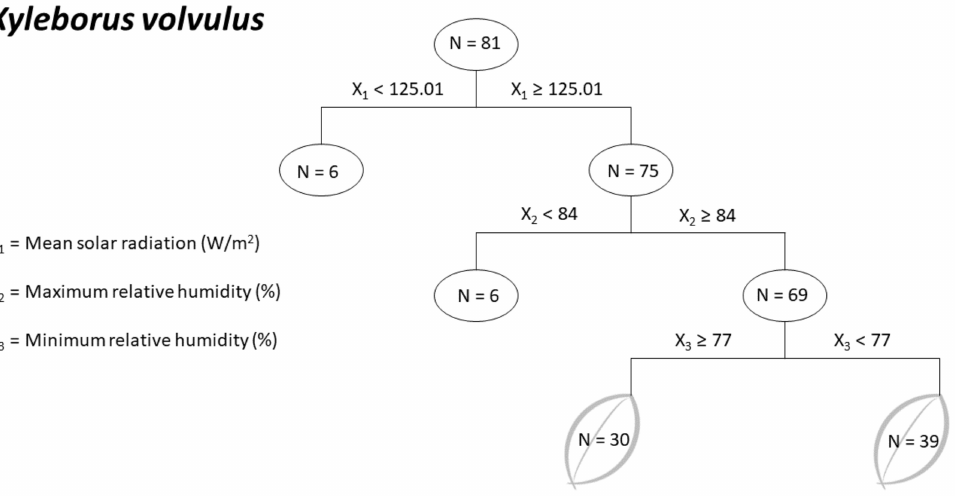
Figure 8. Decision tree schematic for Xyleborus volvulus abundance using weather conditions as explanatory variables.